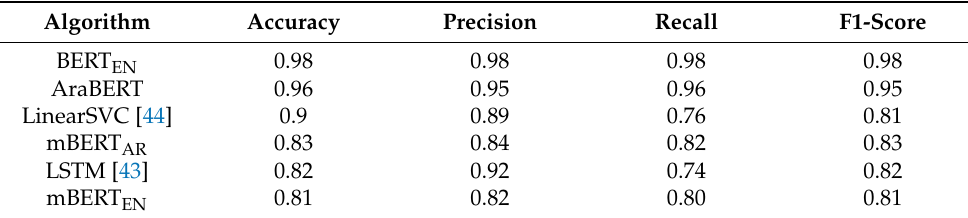
Table 3. Classification Performance Scores. Algorithm